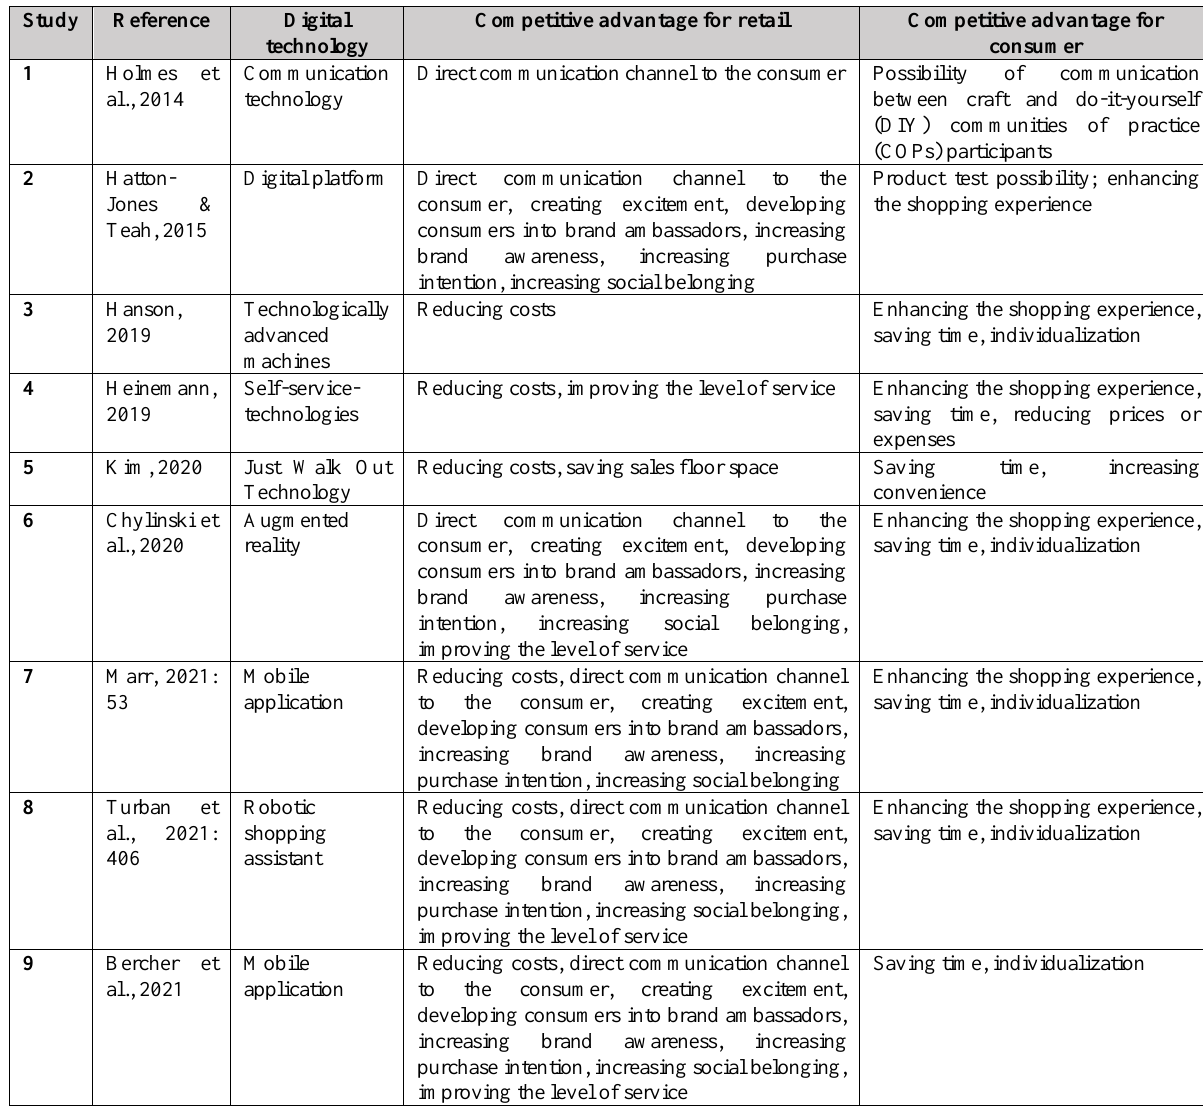
Table 5. Systematization of Possible Achieved Competitive Advantages Using Digital Technologies from